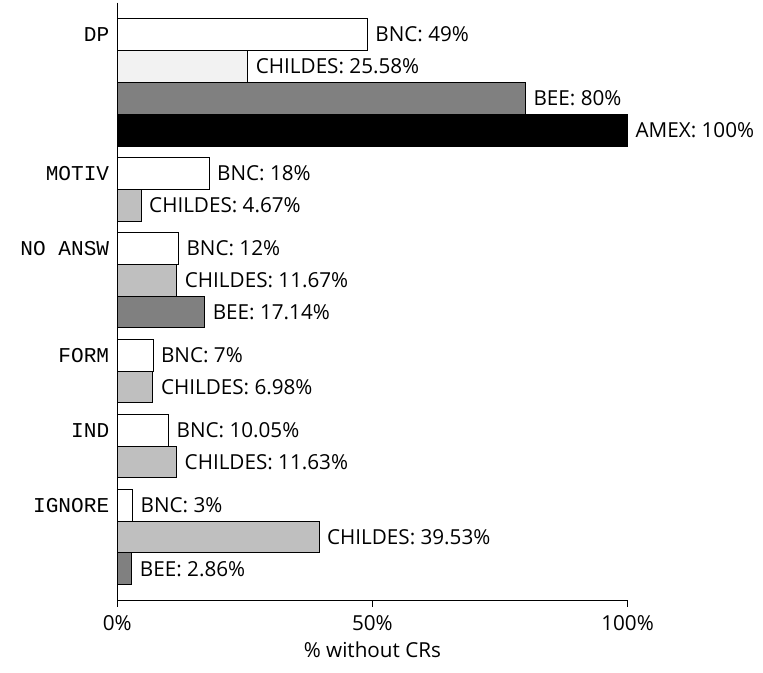
Figure 1: Summary of the distributions